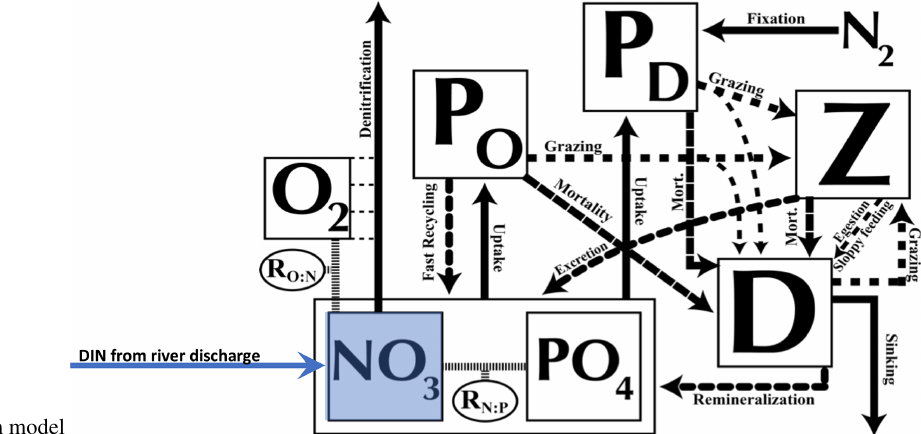
Figure 1. Ecosystem model schematics for the NPZD model with the prognostic variables (in square boxes) and the fluxes of material between them, indicated by arrows. The prognostic variables include two nutrients, nitrate (NO 3 ) and phosphate (PO 4 ), two phytoplankton (nitrogen fixers P D and other phytoplankton P O ) as well as zooplankton (Z), sinking detritus (D), and dissolved oxygen (O 2 ). Nitrate (NO 3 ) and phosphate (PO 4 ) are linked through exchanges with the biological variables by constant (Redfield) stoichiometry of organic matter. See further details in the text. Figure updated from Keller et al. (2012).